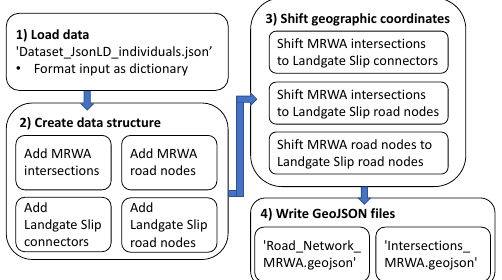
Figure 8. The approach of the Python script (P3) is indicated in four stages (load data, create data structure, shift geographic coordinates and write GeoJSON files).